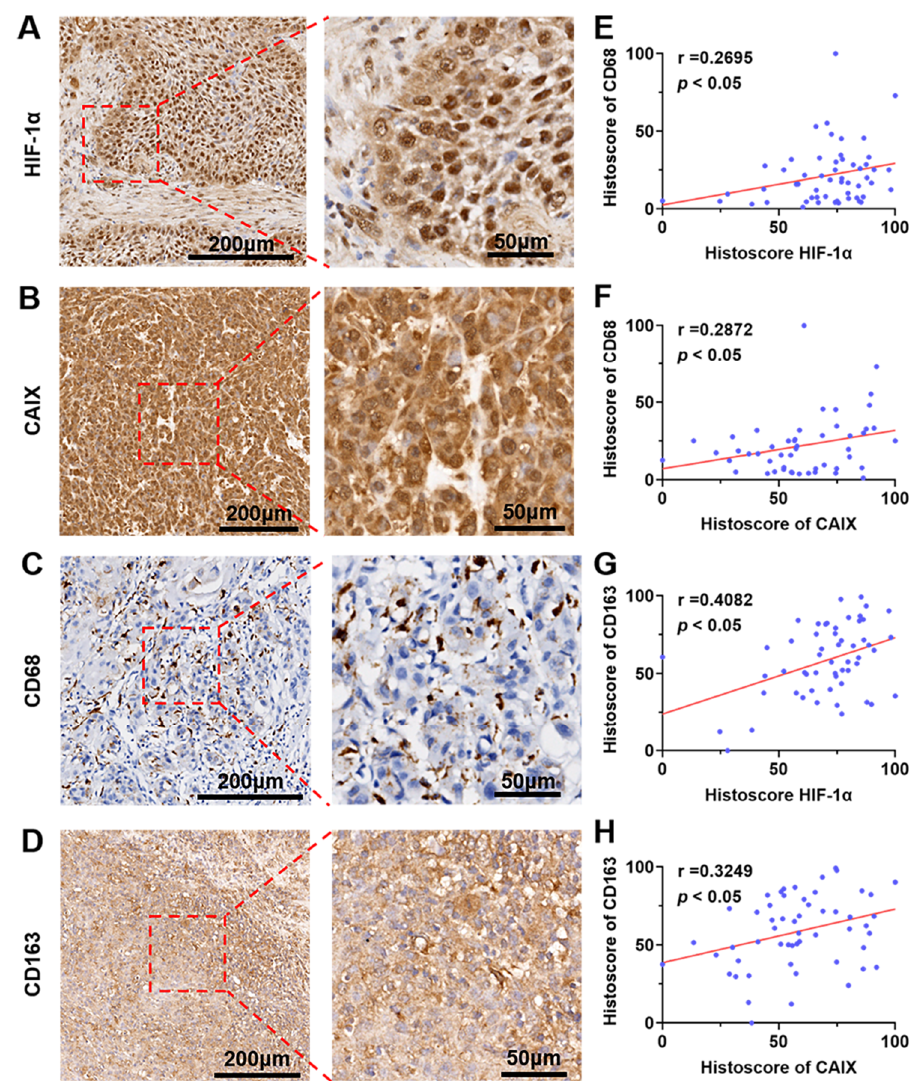
Figure 5. Hypoxia-relative gene expression was positively correlated with CD68 + /CD163 + TAM in human OSCC. Representative images of ( A ) HIF-1α, ( B ) CAIX, ( C ) CD68, and ( D ) CD163 expression in human OSCC. The correlation analysis of ( E ) HIF-1α and CD68, ( F ) CAIX and CD68, ( G ) HIF-1α and CD163, and ( H ) CAIX and CD163 in human OSCC ( n = 55).